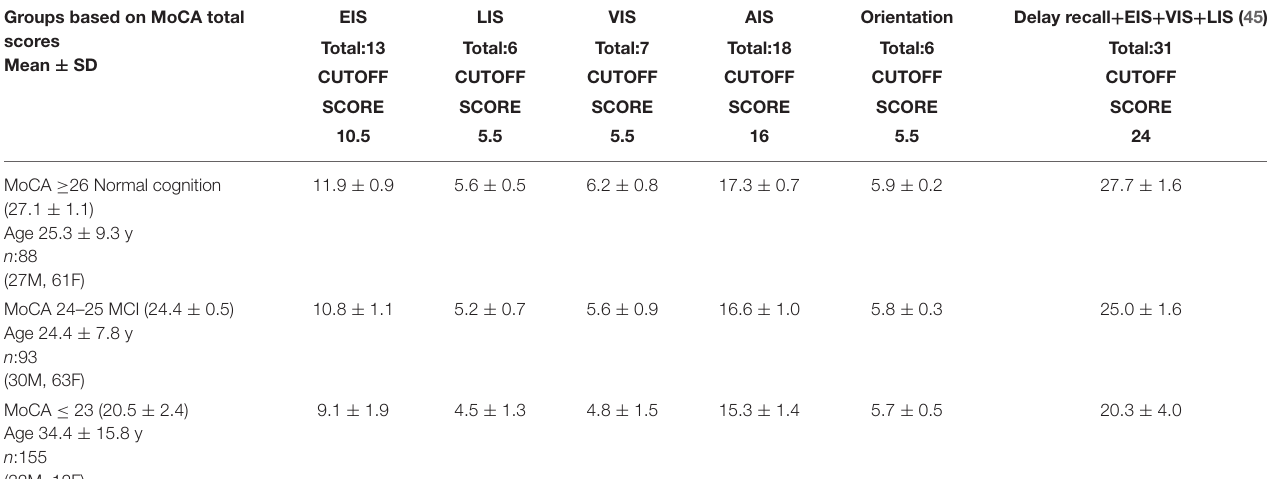
TABLE 3 | Cognitive domains index scores. Groups based on MoCA total